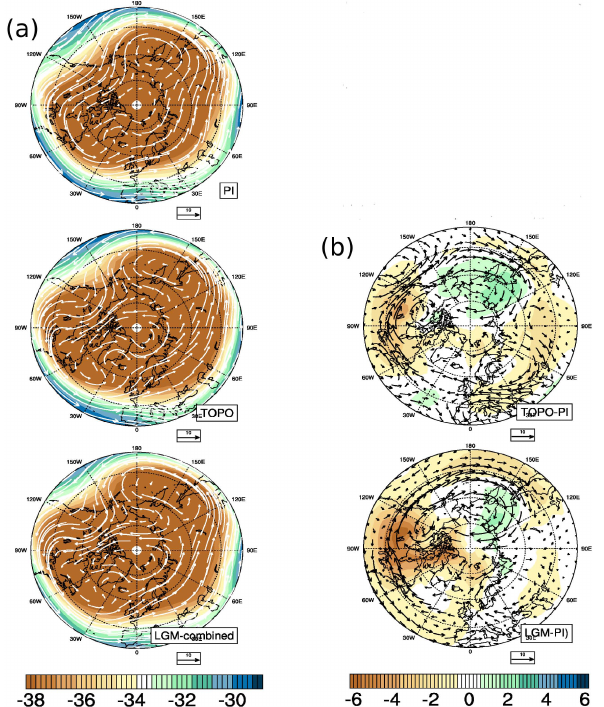
Fig. 11. 500hPa winter (DJF) circulation. Left panels: δ 18 O (‰) in the vapor and wind vectors (ms − 1 ) overlaid for the PI, topography and LGM-combined experiments; right panels: the difference of the same from the PI control run.